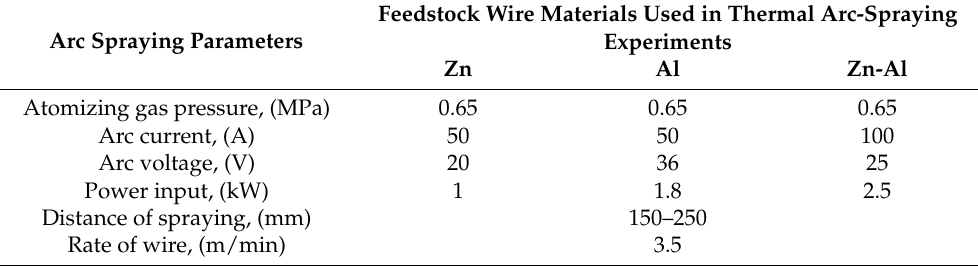
Table 2. Arc-spraying parameters used to obtain three types coatings from of 2 mm feedstock wire